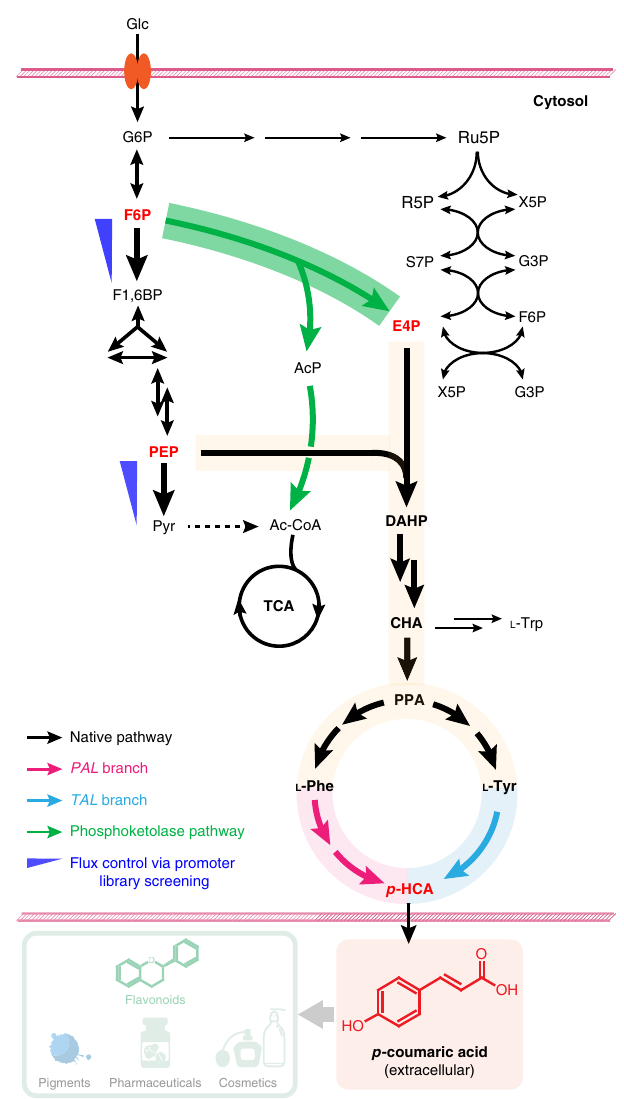
Fig. 1 Rewiring yeast central carbon metabolism for ef fi cient